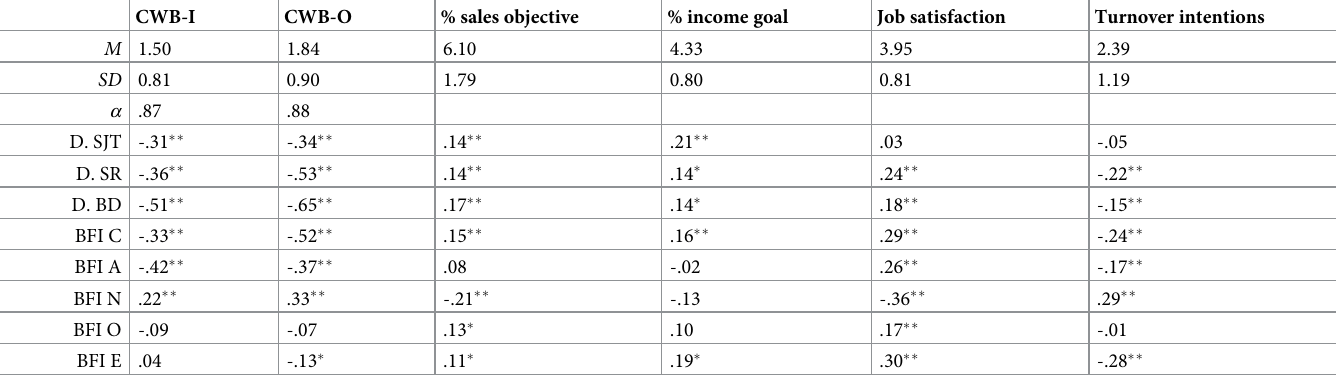
Table 4. Correlations between personality and work-related outcomes.